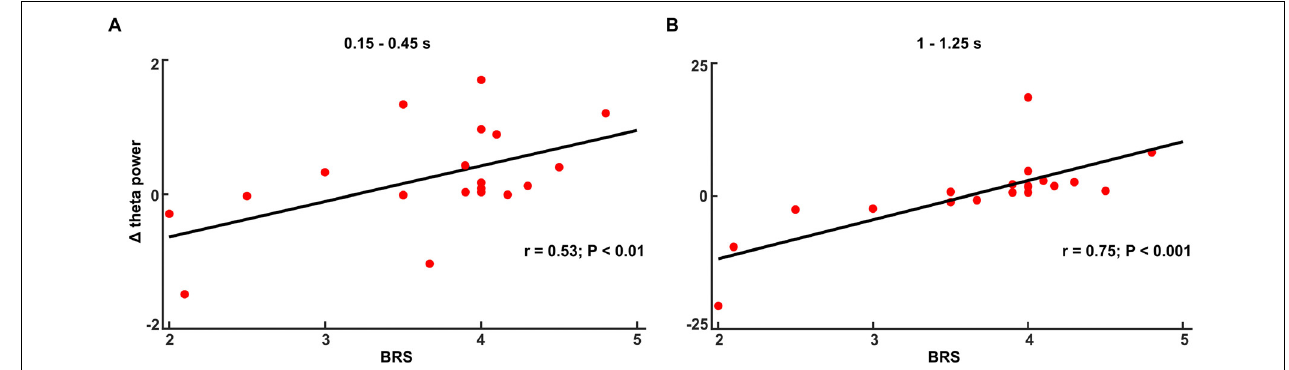
FIGURE 8 | The increased theta power during fear processing ( (cid:49) : CS+ – CS–) correlated with Brief Resilience Scale (BRS) score in the time window (A) 0.15–0.45 s and (B) 1–1.25 s in TMS